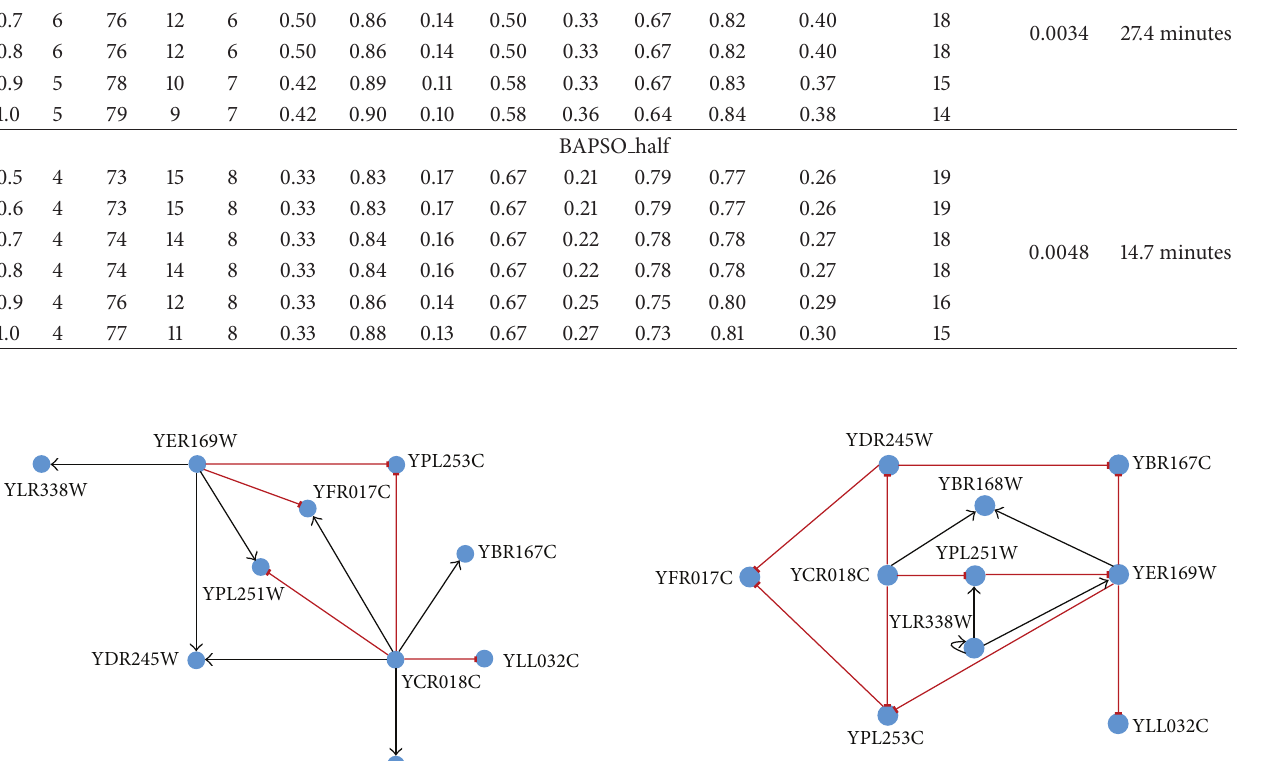
Figure 7: Inferred network obtained by the proposed model for 50 time